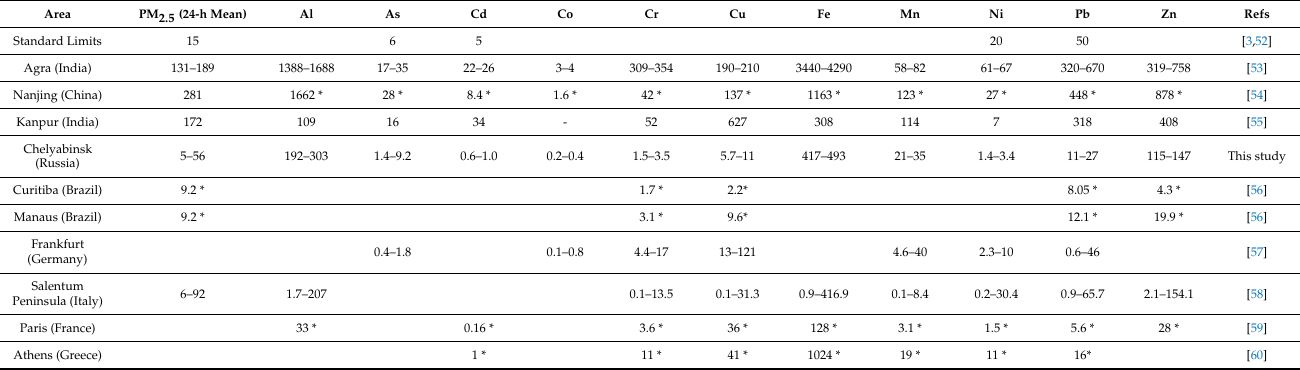
Table 4. Comparison between metal(loid)s (ng/m 3 ) and PM 2.5 ( µ g/m 3 ) concentrations at different sites in the world. Area PM2.5